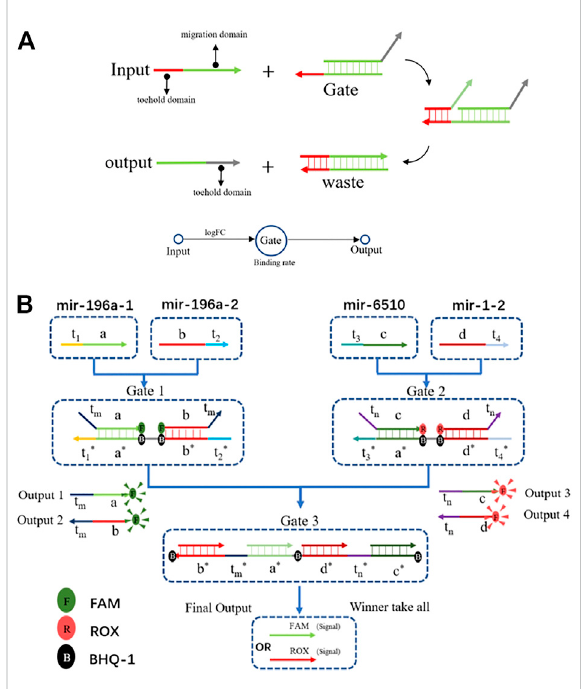
FIGURE 3 (A) The DSD mechanism, the input strand has two domains: the toehold domain and the migration domain. Input strand can displace the output strands with toehold domain mediated. It is a simple one input one output DSD system. (B) The DSD computingsystem.Fourinputsoneoutputssystem.Outputresults were reported by fl uorescent